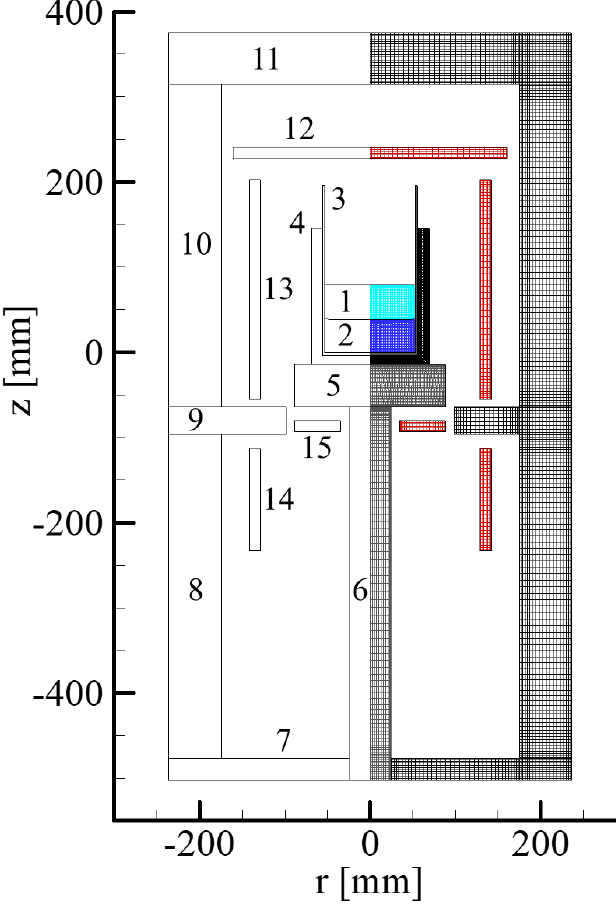
Figure 4. Configuration and domain partition of the furnace. 1: melt, 2: crystal, 3–4: crucibles, 5–6: pedestals, 7–11: heat shields, 12–15: heaters Reproduced with permission from S. Hisamatsu, H. Matsuo, S. Nakano, K. Kakimoto, Journal of Crystal Growth; published by Elsevier, 2009, [17].